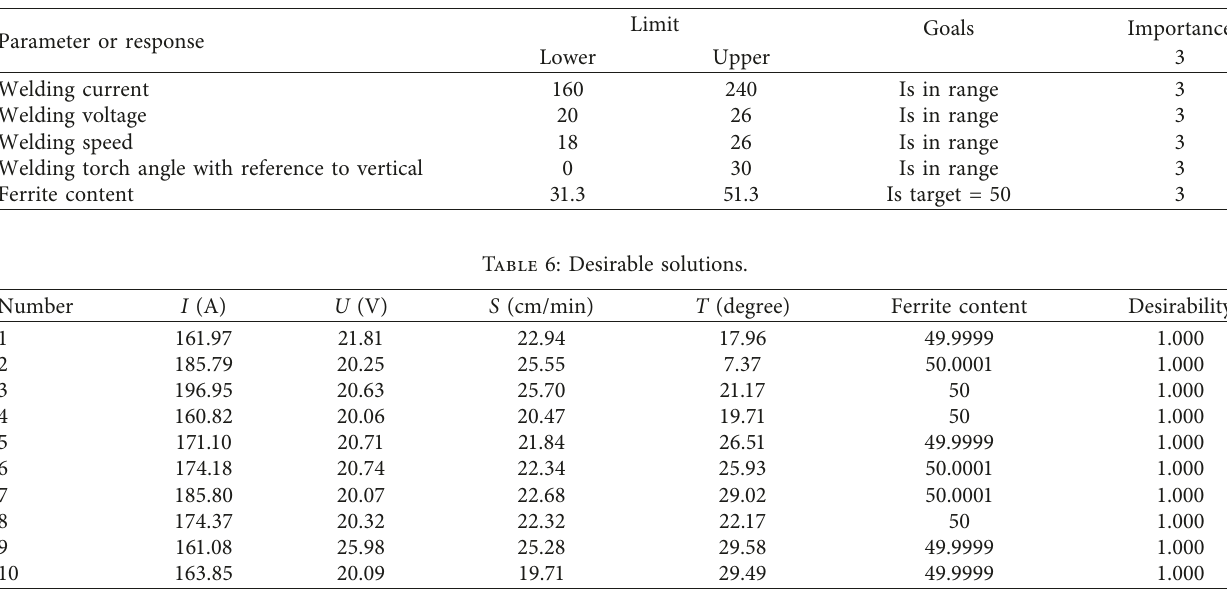
Figure 4: (a) SEM micrograph from 2205 DSS sample welded at trial no. 9 ( I � 240A, U � 26 V, S � 22cm/min, and T � 0 degree); (b) EDS of σ phase corresponding to (a); (c) EDS of austenite phase corresponding to (a); and (d) EDS of ferrite phase corresponding to (a). Table 5: Process parameter and response constraint.